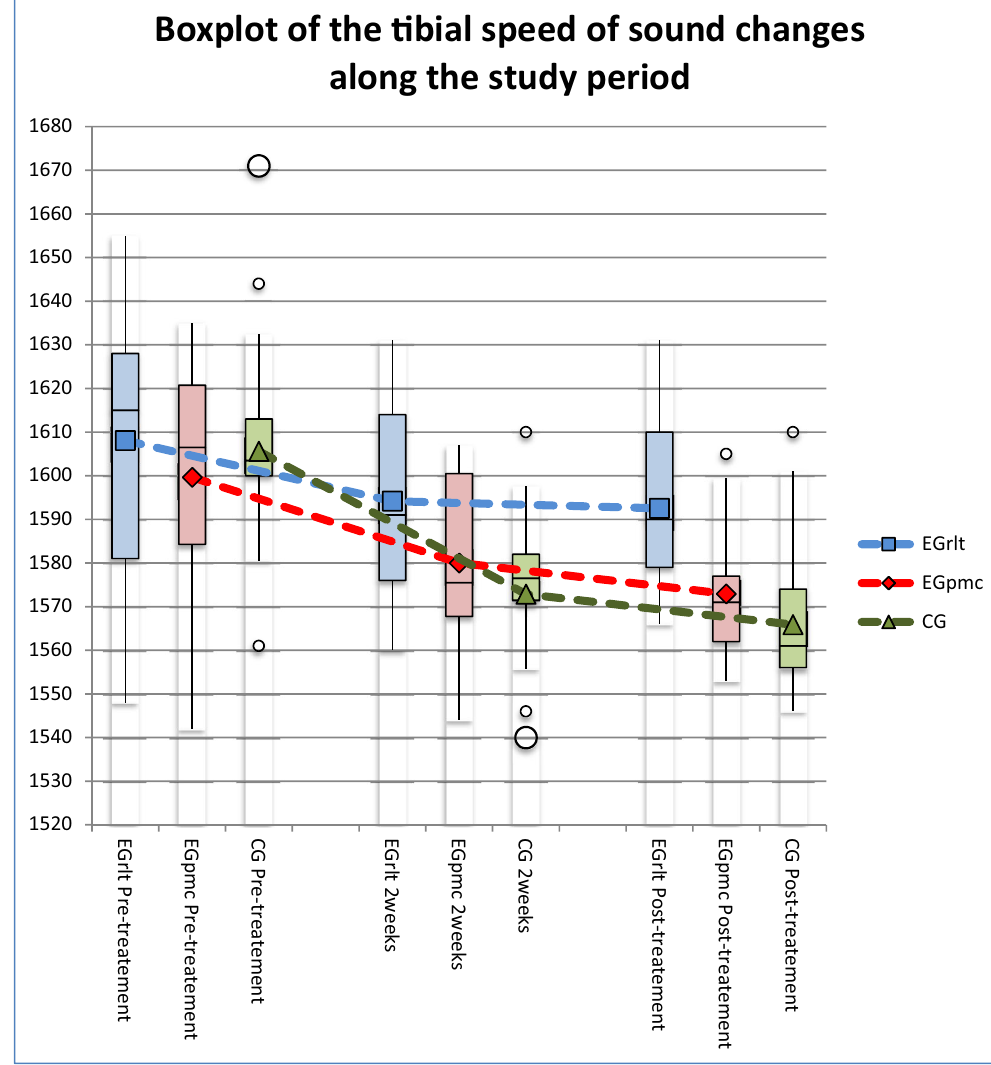
Figure 2. Box plot of the tibial speed of sound changes during the study